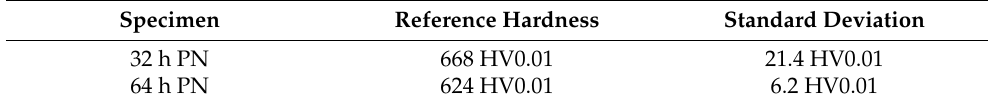
Table 7. Hardness of the reference samples after the initial nitriding